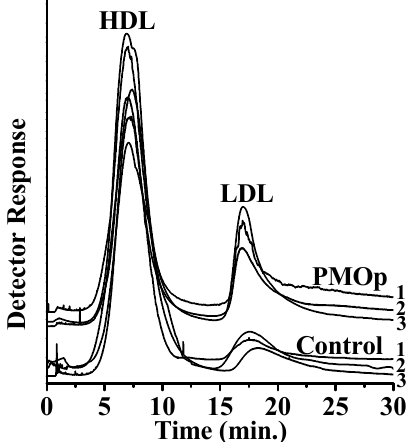
Figure 1. Fractograms of plasma samples (stained with Sudan Black B) from patients with PMOp and controls of postmenopausal females showing the separation of HDL and LDL by semi-prep AF4 obtained at outflow rate/crossflow rate = 0.4/3.6 in mL/min. Detections were at λ = 600 nm.